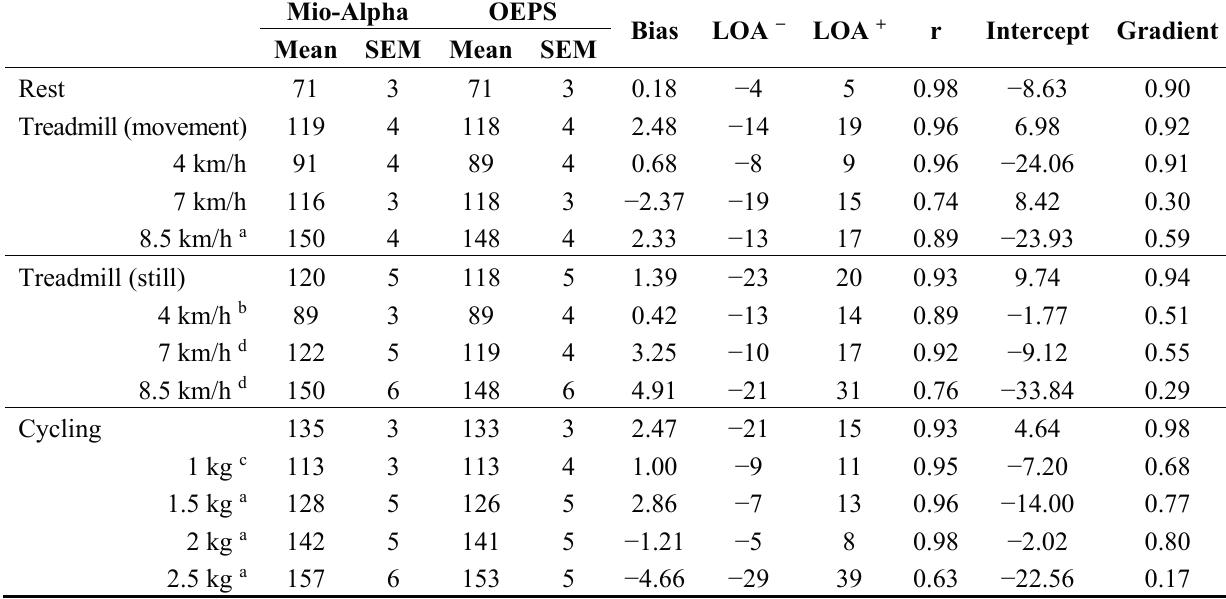
Table 2. Bias, 95% limits of agreement (LOA) and correlation coefficient (r) of HR between Mio-Alpha and the OEPS during Rest, Walking, Running and Cycling Activity (16 subjects).